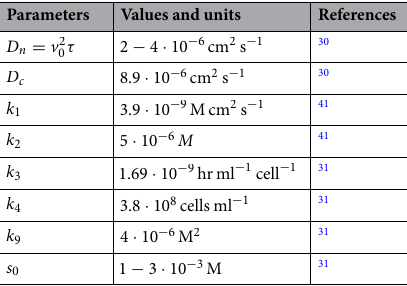
Table 1. Parameter network values.